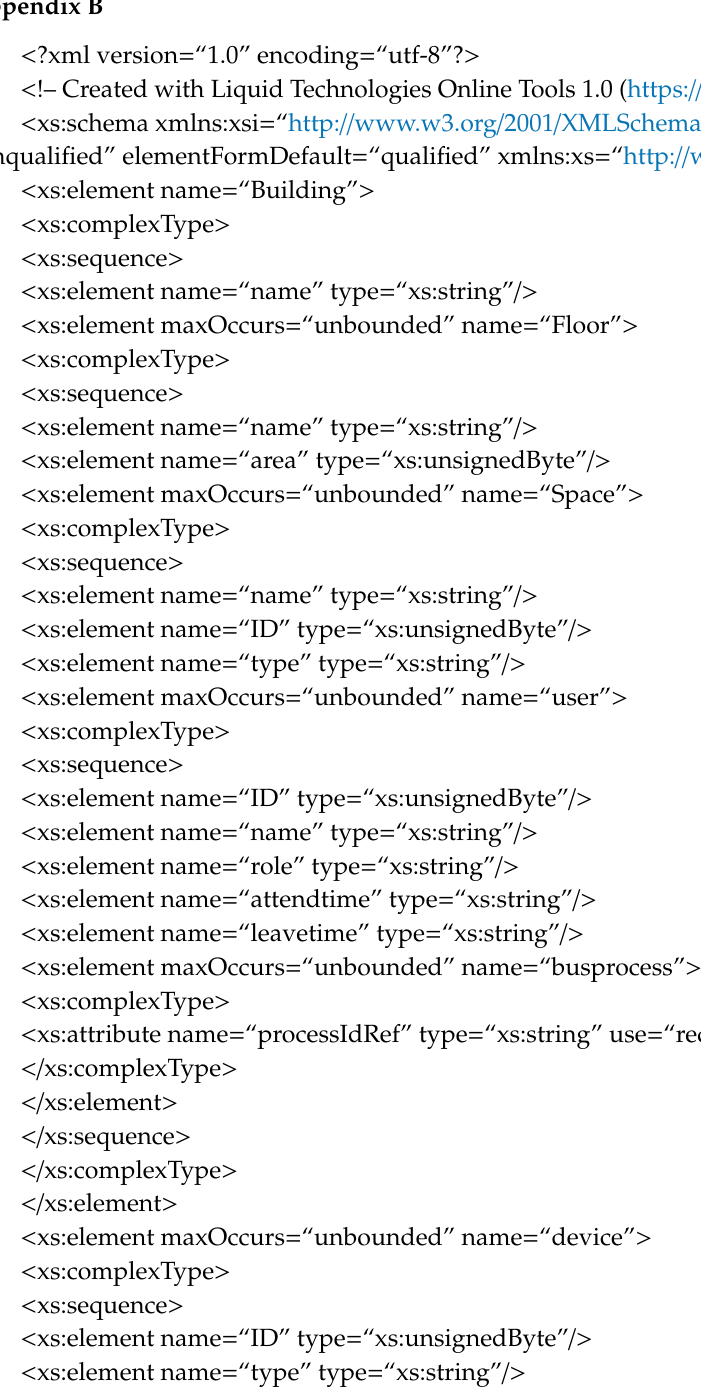
Figure 2. Business process flexibility calculation: ( a ) Lighting and ( b ) office devices. Figure A2. Business process flexibility calculation: ( a ) Lighting and ( b ) o